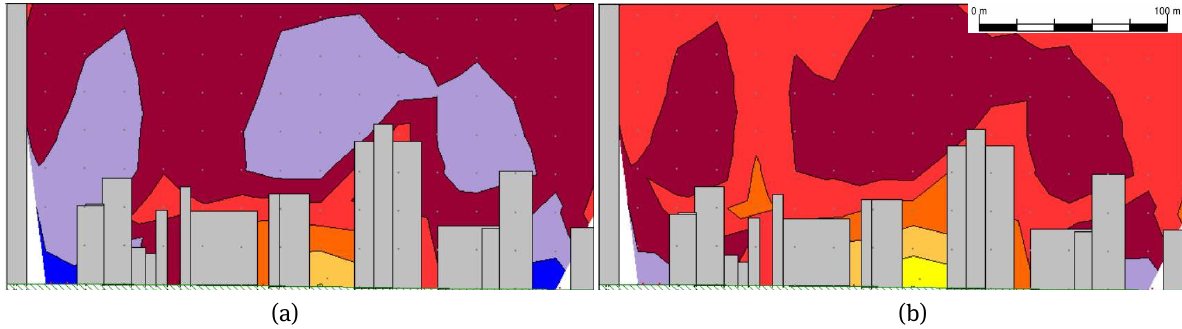
Figure 10: Cross section A, as indicated on Figure 8: (a) Pre-pandemic scenario and (b) pandemic one on the